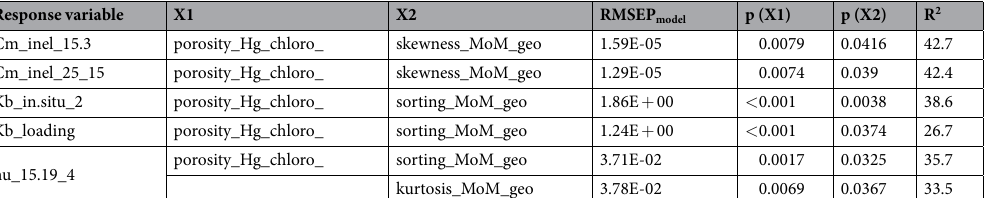
Table 2. Overview of variables tested using bivariate statistical models. Nomenclature similar to Table